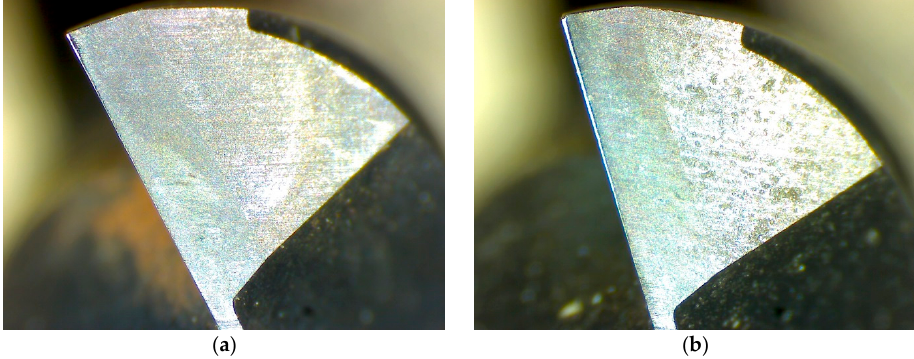
Figure 12. ( a ) Tool wear at cut distance 500 mm; and ( b ) tool wear at cut distance 2500 mm.